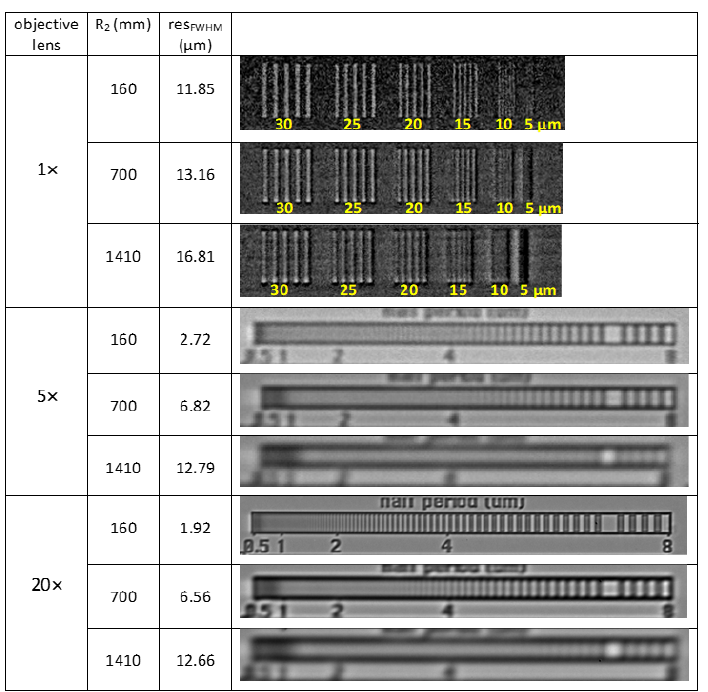
Figure 5. Resolution pattern images in horizontal direction taken using 1× objective lens (for QRM MicroCT test pattern) and using 5× and 20× objective lenses (for Xradia X500-200-30 test pattern) at several sample-to-detector distances of 160 mm, 700 mm, and 1410 mm with corresponding theoretical res FWHM values horizontally. The numbers below the test pattern of 1× images indicate the corresponding linewidth in μm. The half period or linewidth in μm unit of the 5× and 20× objective lens images are visible on the pattern itself.